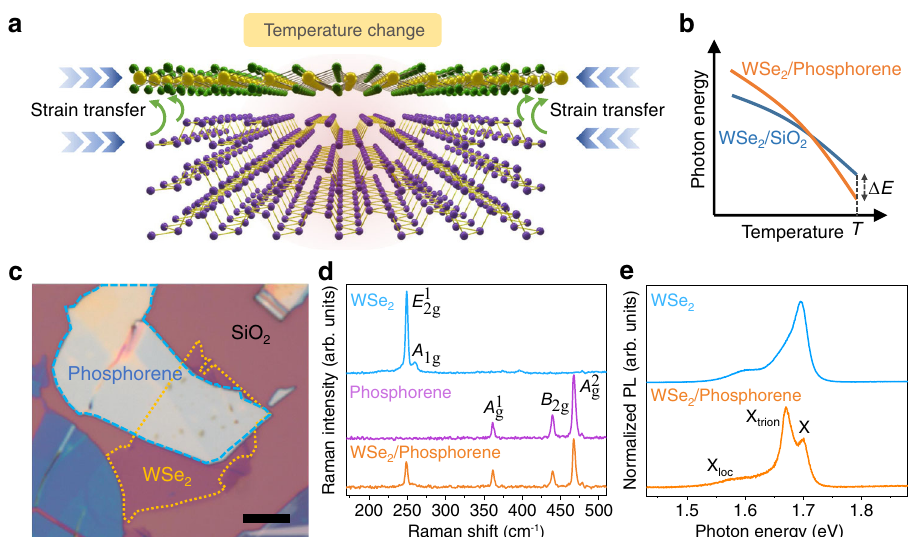
Fig. 2 WSe 2 /phosphorene heterostructure for STD and ISTD investigations. a Monolayer WSe 2 serves as a strain meter to probe the thermal deformation of the top phosphorene layer. Here, the blue arrows indicate that the in-plane lattice contraction when temperature decreases. The green arrows describe the strain transfer from phosphorene to WSe 2 through interlayer interactions. b Schematic evolution trends of photon energy in WSe 2 / phosphorene/SiO 2 and WSe 2 /SiO 2 systems as a function of temperature. Photon energy difference ( Δ E ) between WSe 2 /phosphorene/SiO 2 and WSe 2 / SiO 2 at temperature T can directly re fl ect the thermal deformation of WSe 2 . c Optical image of a WSe 2 /phosphorene heterostructure. The scale bar is 5 μ m. d Raman spectra of isolated monolayer WSe 2 , isolated phosphorene, and WSe 2 /phosphorene heterostructure at room temperature. e Photoluminescence (PL) spectra of isolated monolayer WSe 2 and WSe 2 /phosphorene heterostructure at 180 K. Here, X loc , X trion and X denotes the localized, charged and neutral exciton of monolayer WSe 2 ,